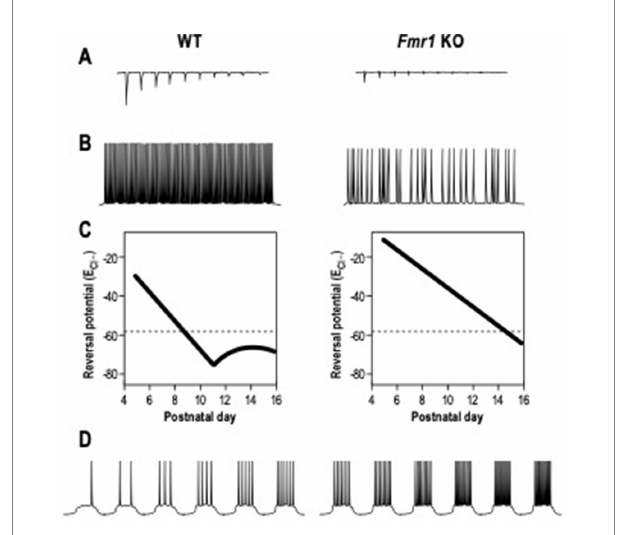
FIGURE 2 Electrophysiological alterations in Fragile X Syndrome. (A) The local excitation of interneurons, induced by excitatory neurons and measured as amplitude of excitatory post-synaptic currents, is reduced in Fmr1 KO mice compared to WT mice. (B) The action potentials firing of interneurons induced by DHPG, agonist of group 1 metabotropic glutamate receptor (mGluR), is decreased in Fmr1 KO mice. (C) The chloride reversal potential (E Cl -) remains depolarized in excitatory neurons of Fmr1 KO mice during neuronal development. (D) The firing action potential rates in excitatory neurons is increased in Fmr1 KO mice than in